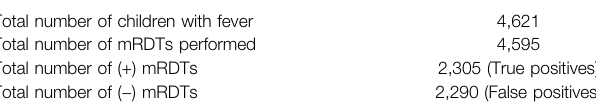
TABLE 2 | Historical DHIS2 data for malaria in Kano State, Nigeria 2017. Total number of children with fever